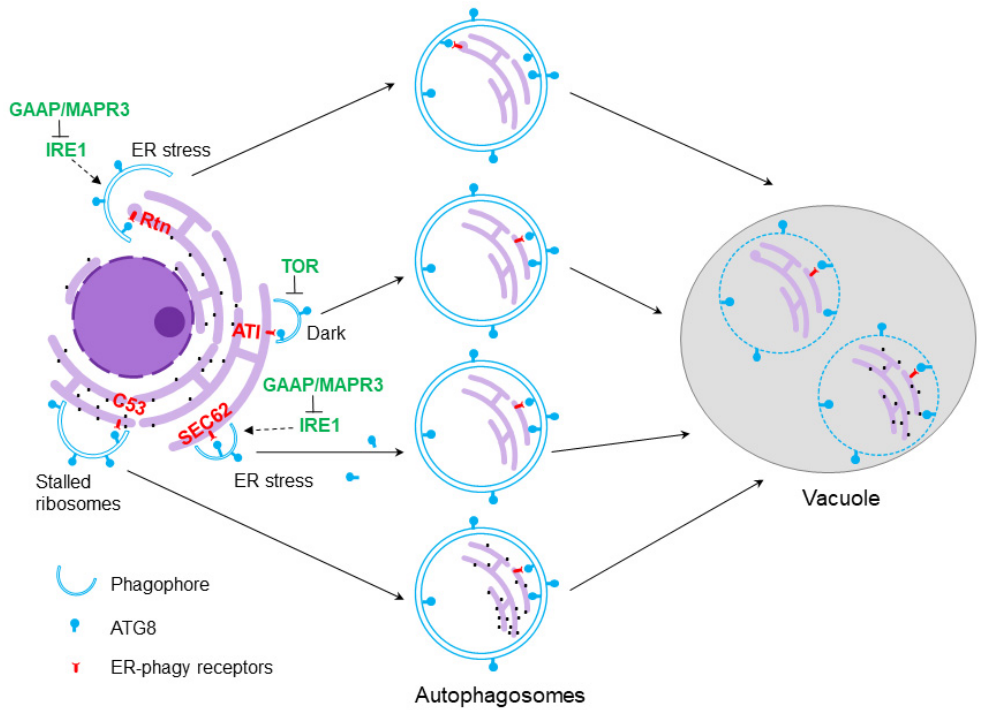
Figure 1. Working model for plant endoplasmic reticulum (ER)-phagy. Multiple receptors function in selecting ER for autophagic degradation: (1) reticulon (Rtn) proteins can remodel ER structure and select ER for degradation during ER stress via binding to highly curved membranes; (2) ATG8-Interacting (ATI) proteins function in dark stress-mediated ER-phagy; (3) SEC62 acts as a receptor for ER-phagy during ER stress; (4) C53-mediated ER-phagy is triggered by stalled ribosomes on the ER. Black dots on the ER denote ribosomes. Potential regulators are shown in green.